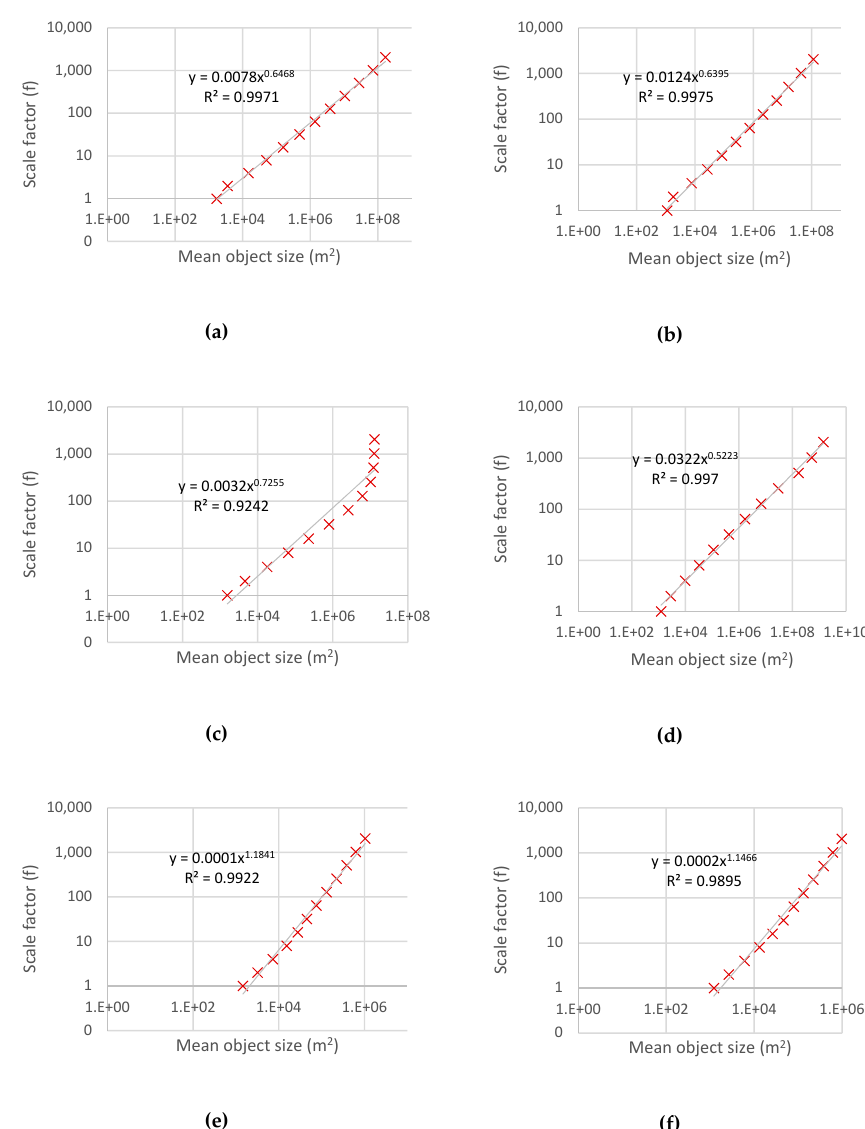
Figure 7. Log-log plots of scale factor vs. mean object size and the extracted predictive equations for: ( a ) Pinios elevation; ( b ) Acheloos elevation; ( c ) Pinios slope; ( d ) Acheloos slope; ( e ) Pinios flow accumulation; ( f ) Acheloos flow Table 3. Partial and final outputs for elevation in the Pinios river basin; 0-partition level corresponds to the original elevation surface.